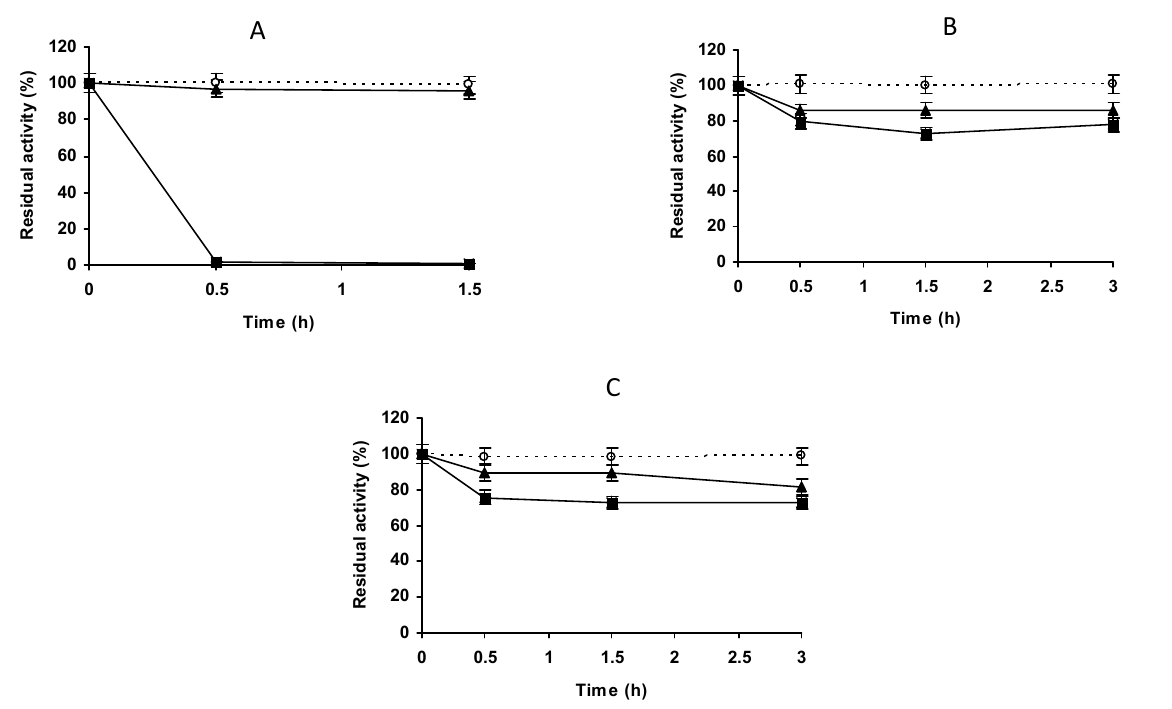
Figure 5. Immobilization courses of PGA (2.5 mg/g) on glyoxyl agarose ( A ) and on vinyl sulfone agarose at different concentrations of sodium chloride in 50 mM sodium phosphate at pH 8.0, 25 °C. ( B ) 500 mM; ( C ) 1 M. Empty circles with dashed line: reference suspension. Full triangles with solid line: suspension. Full squares with solid line: supernatant. Other specifications are described in Methods.